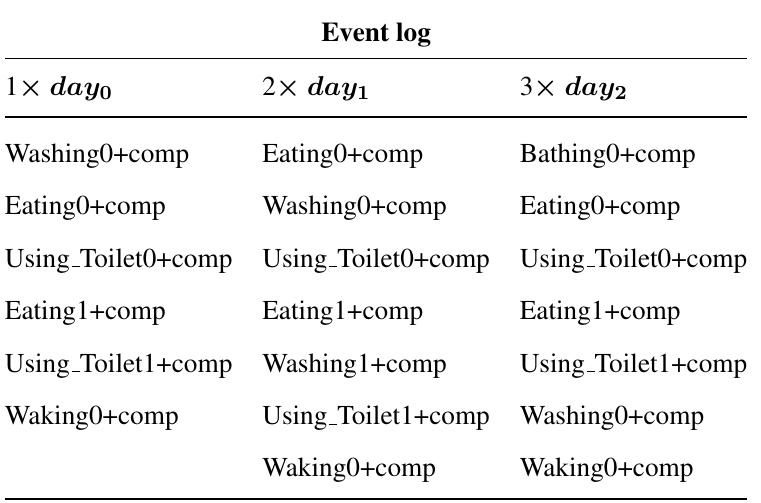
Table 1. Event log containing three daily